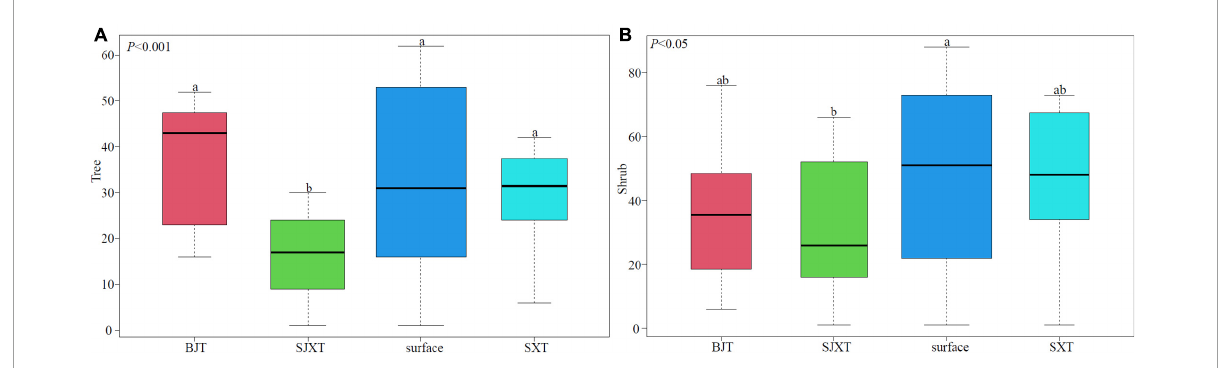
FIGURE2 Differences in species composition of forests between sites, with different lowercase letters indicating significant differences. (A) Tree, (B)